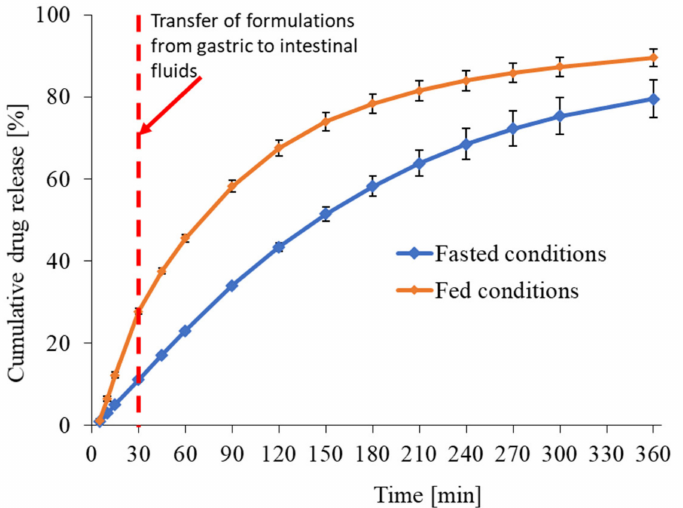
Figure 1. In-vitro release profile of Riva from Xarelto IR tablet (20 mg strength) using USP 4 apparatus. The tablets were transferred from FaSSGF (pH 1.6) and FeSSGF (pH 4.5) media to FaSSIF (pH 6.5) and FeSSIF (pH 5.0) media, respectively, after 30